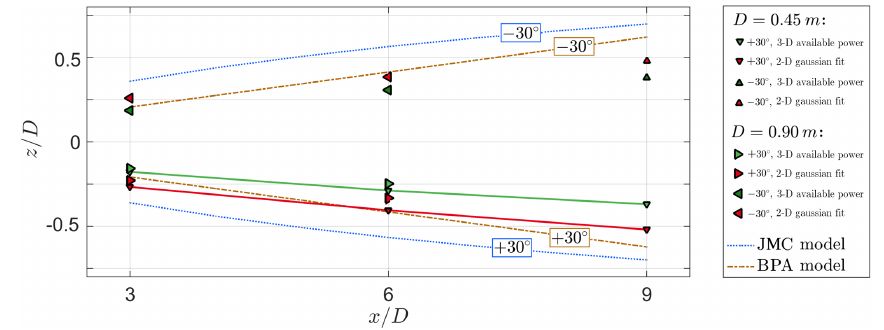
Figure 8. Calculated wake deflection δ ( z/D ) for the NTNU rotor ( D = 0.90m), a downscaled NTNU rotor ( D = 0.45m), and the wake deflection model of Jiménez et al. and of Bastankhah and Porte-Agél. The inflow turbulence level is TI A = 0.23%.